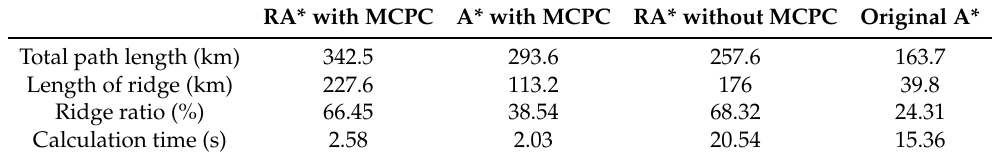
Table 4. Data comparison of different